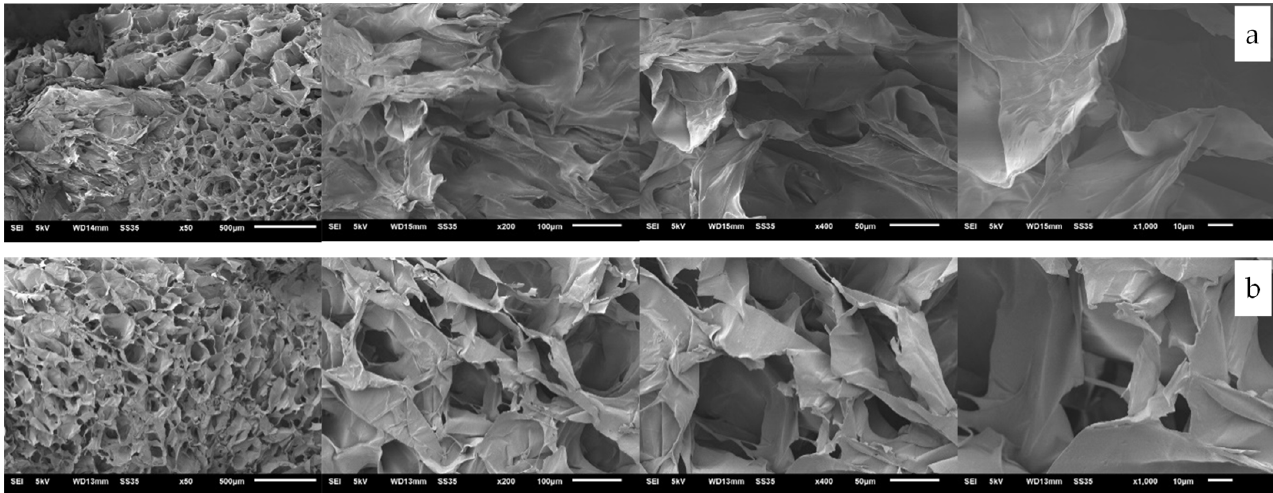
Figure 6. SEM images of the extracted collagen/gelatin from ( a ) the skin and ( b ) the bone.